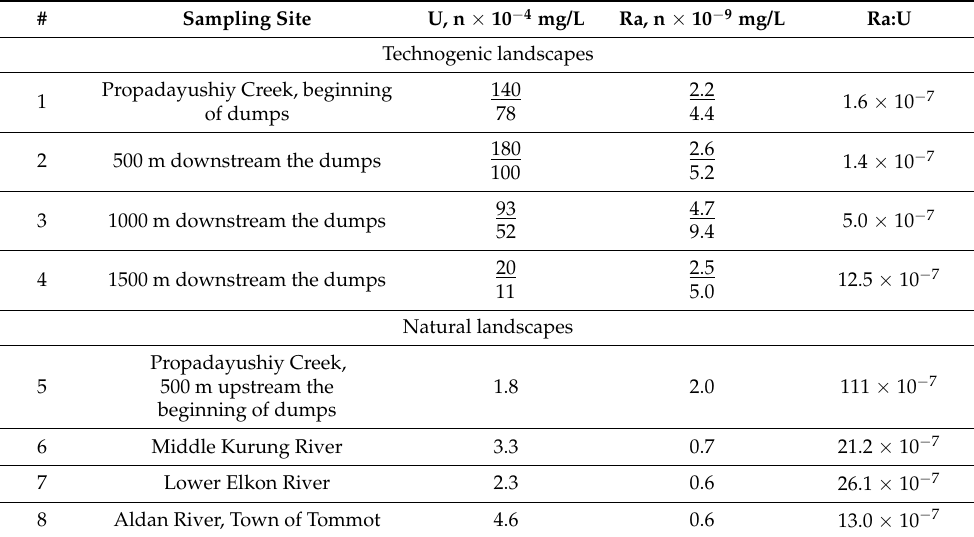
Table 4. Content of radionuclides in the surface waters of technogenic and natural landscapes of Southern